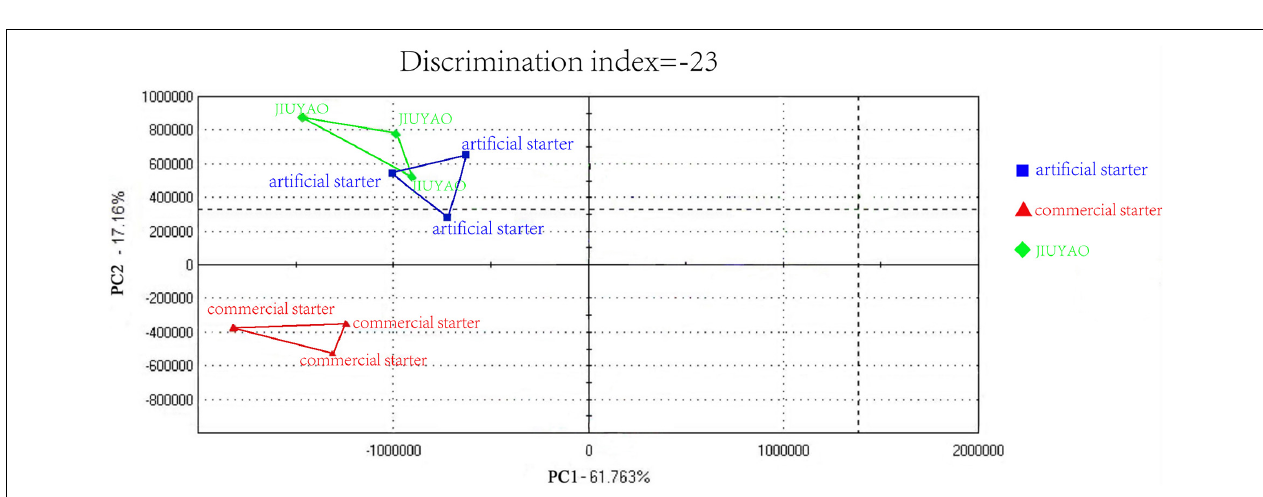
FIGURE 5 | Principal component analysis of the three Chinese rice wine samples brewed with three different starters.